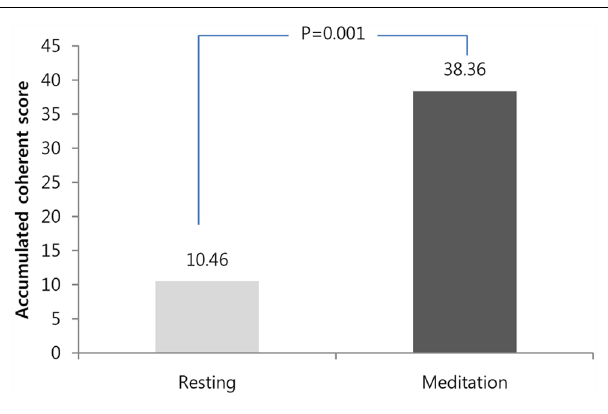
FIGURE 1 | Comparison of the accumulative coherence scores accumulative coherence scores (ACSs) between baseline and during meditation. Significant increases were observed in the ACS. ACS means the longest length of an epoch in which each participant stayed in a heart coherent state.